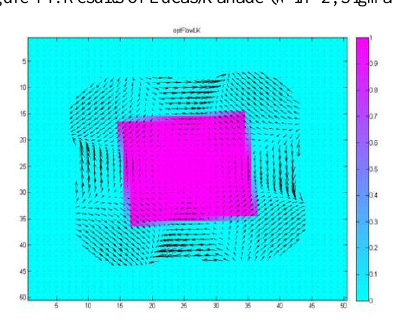
Figure 14. Results of Lucas/Kanade (Win=2, Sigma=3)